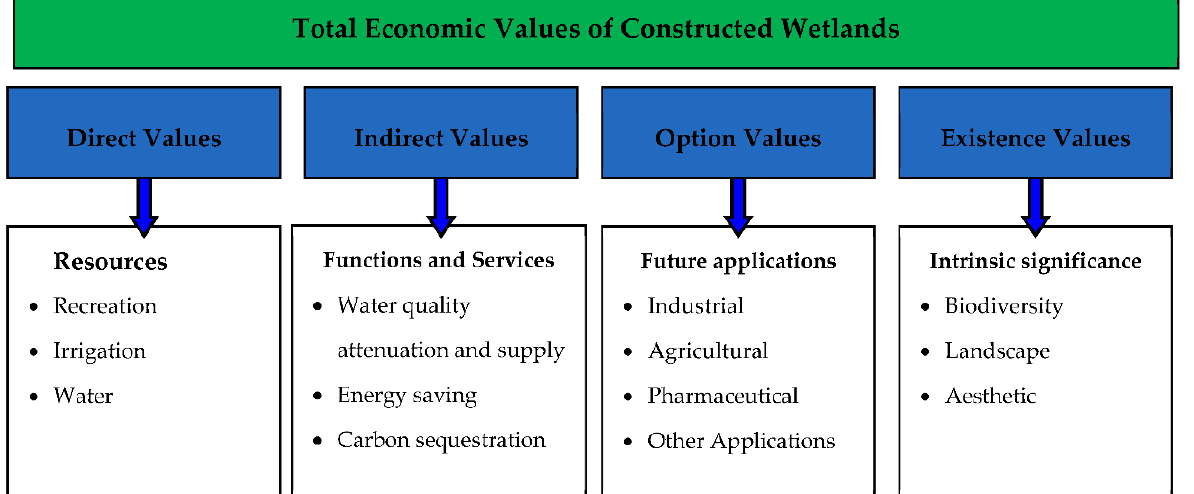
Figure 1. Total economic values of CWs.